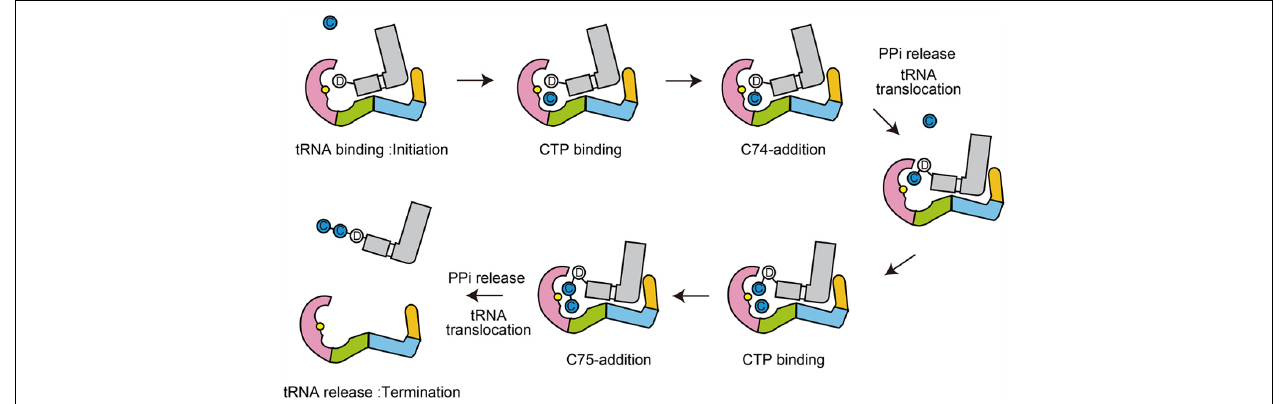
FIGURE 7 | Mechanism of CC-addition by class-II CC-adding enzymes. Schematic representation of the CC-adding reaction by class-II CC-adding enzymes. The head, neck, body, and tail domains are colored magenta, green, cyan, and orange, respectively. tRNAs are colored gray. Catalytic sites are colored yellow in the head